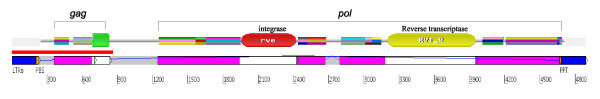
Rice Route66 complete element using Artemis and Pfam annotation. The gag and pol regions are shown. The red line represents the the 1 kb cloned fragment in the different species.